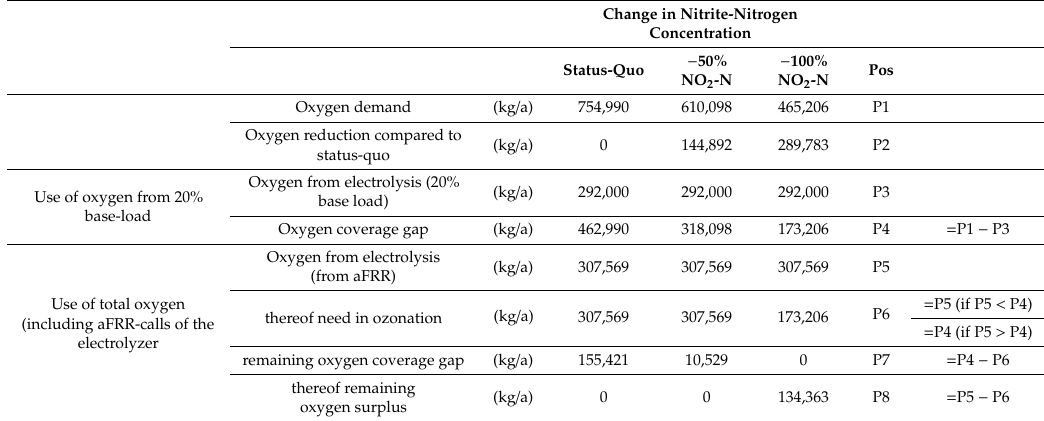
Table A2. Oxygen demand and coverage gaps depending on the nitrite concentration in the feed of the ozonation